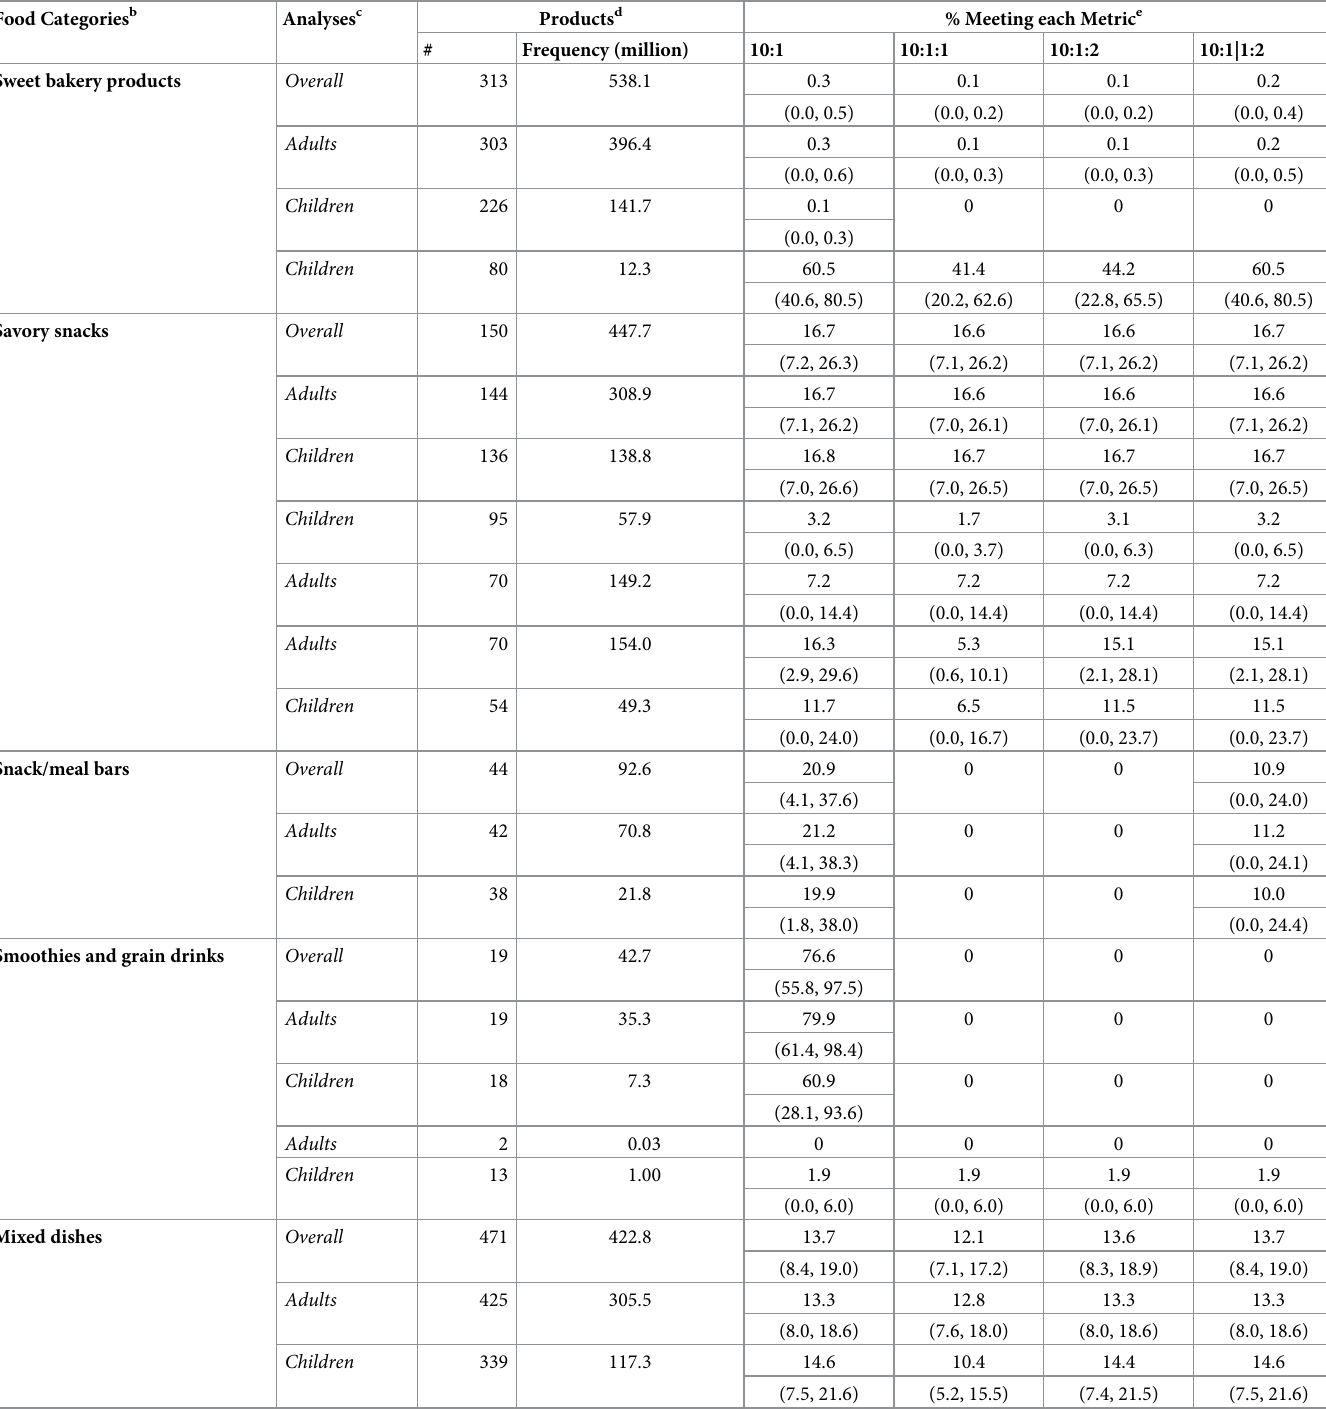
Table 2. Comparison of consumed carbohydrate-rich products meeting each of four proposed metrics for assessing carbohydrate quality by Americans a . Food Categories